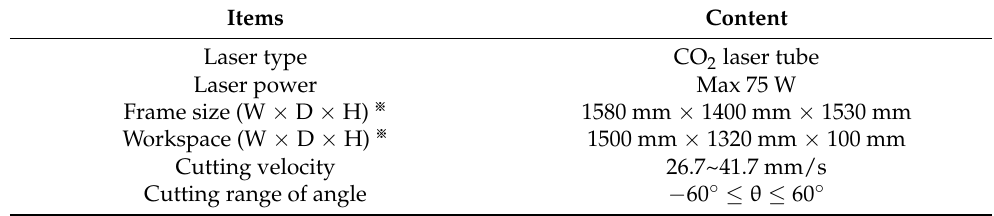
Table 1. Information on the equipment.